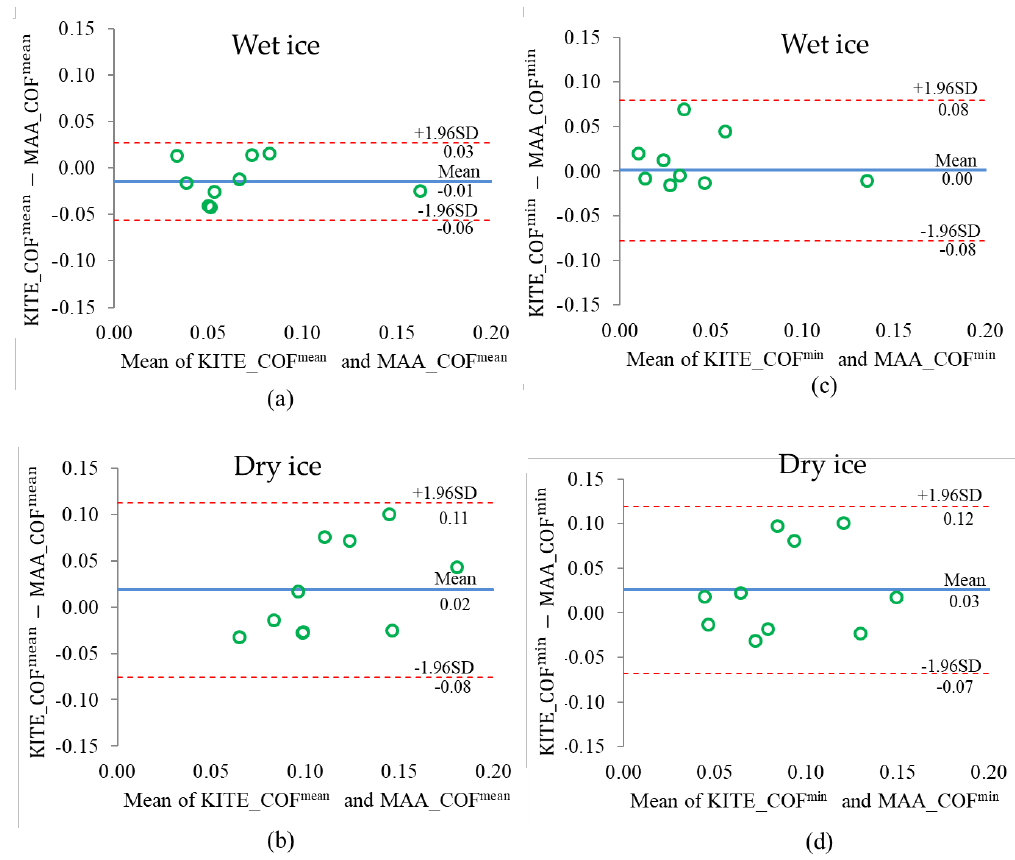
Figure 12. B&A plots for Mean values scenario on ( a ) wet and ( b ) dry ice, and Minimum values scenario on ( c ) wet and ( d ) dry ice conditions.